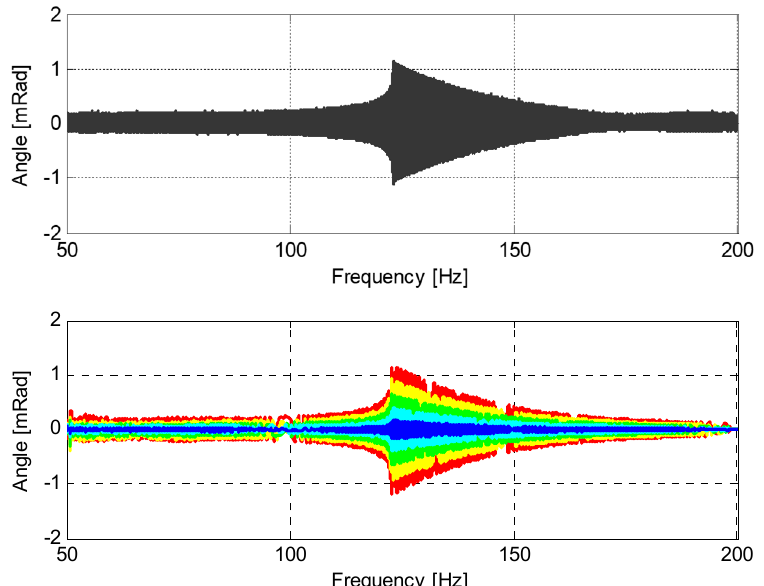
Figure 14. The results of RC testing. Standard RC test results are at the top; the results from the additional accelerometers are at the bottom. Material: Sand 3 (Sa); Isotropic pressure 50 kPa; Frequency spectrum 50–200 Hz; Excitation (torque) amplitude 2 V (– original built-in sensor, – the top sensor, S1, – the second sensor from the top, S2, – the third sensor from the top, S3, – the fourth sensor from the top, S4, – the bottom sensor, S5).